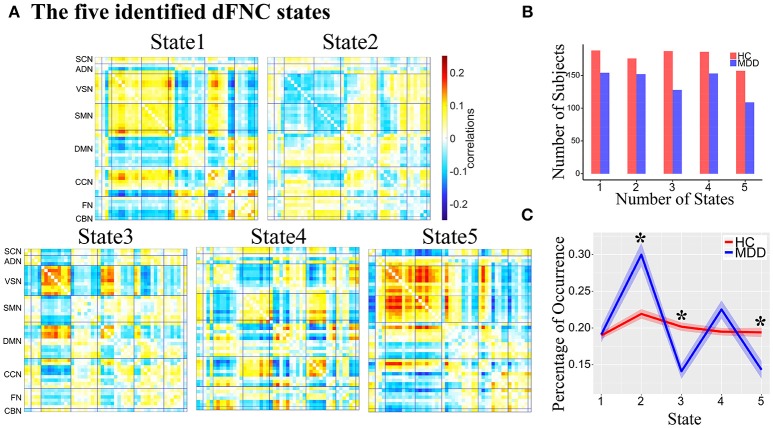
(A) The five identified dFNC states using the k-means clustering method. (B) The number of subjects in each state. (C) The group difference in the percentage of occurrence in each state. Asterisk indicates p < 0.05 (FDR corrected).